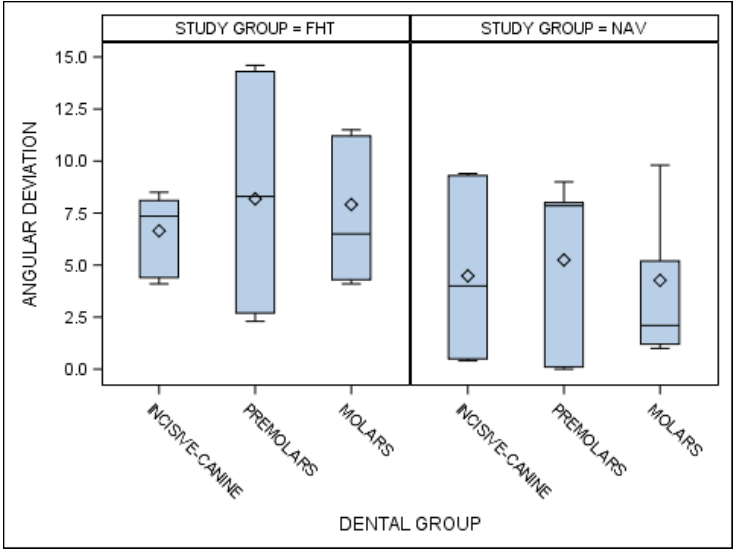
Figure 11. Box plot of the angular deviations of the orthodontic micro-screws placed using the computer-aided static navigation technique and conventional freehand technique in the incisive – canine, premolar and molar dental sectors.